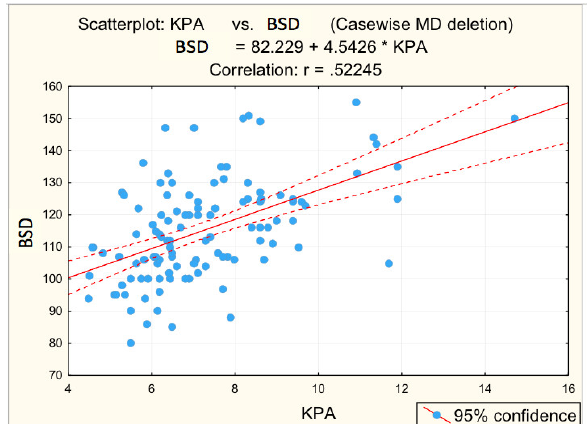
Figure 6. Correlation BMI—fibrosis .